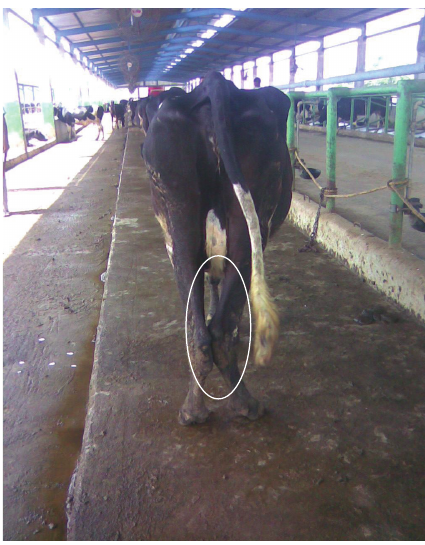
Figure 1: Cow hock: rear leg view index.